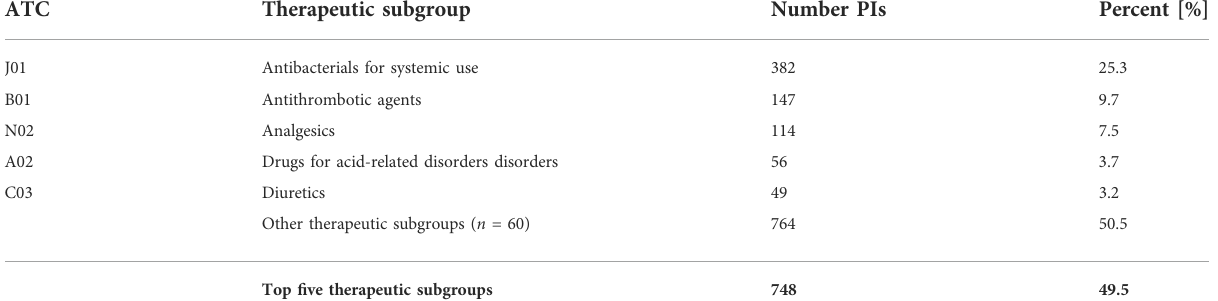
TABLE 3 Top fi ve therapeutic subgroups for PIs.